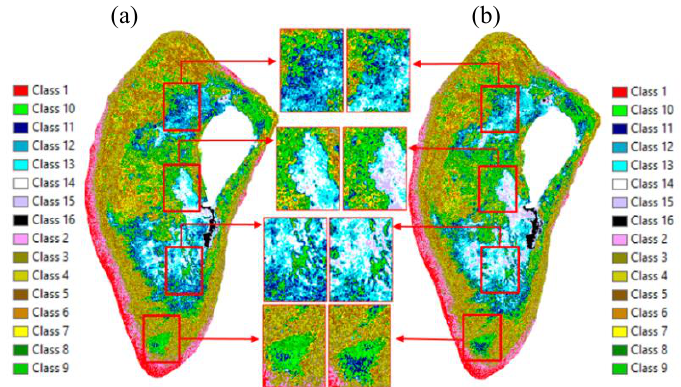
Figure 2. Unsupervised Classification Results of IsoData and K-Means Methods in SPOT-6 images with the application of the Lyzenga Algorithm (a) the classification results of the IsoData Method, (b) the results of the K-Means method